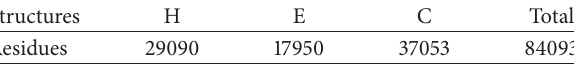
Figure 4: Schematic diagram for filtering 9INSb. Table 5: Structures of the CB513 data